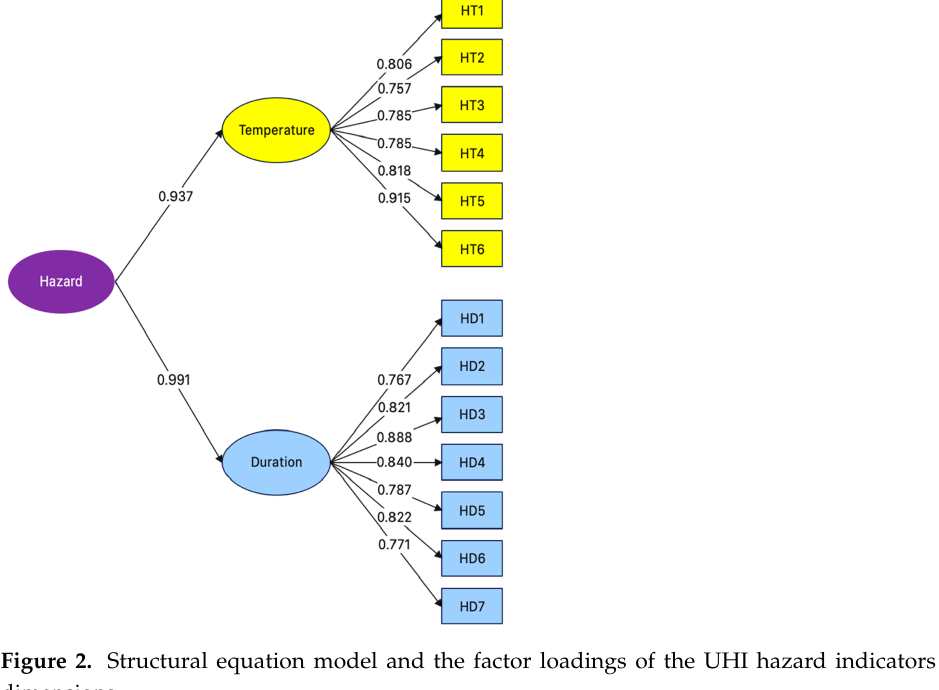
Table 5. First- and second-order CFA of UHI hazard indicators.